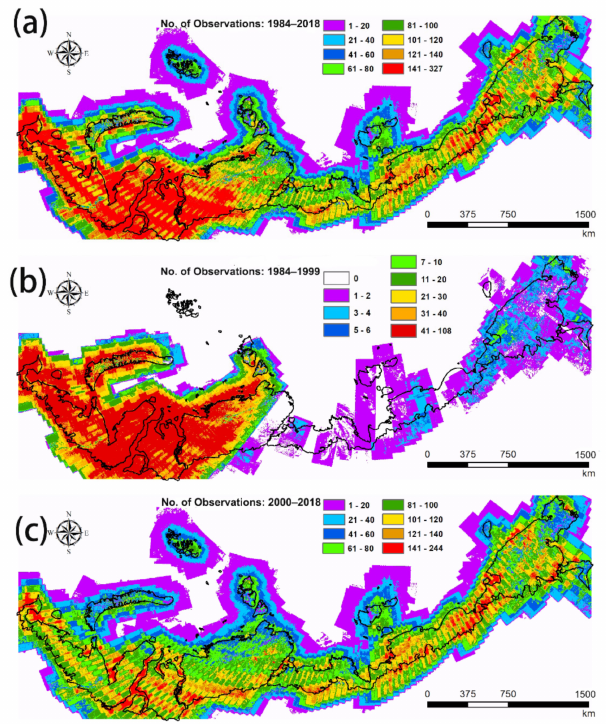
Figure 3. Number of Landsat observations during three periods: ( a ) 1984–2018; ( b ) 1984–1999; ( c )